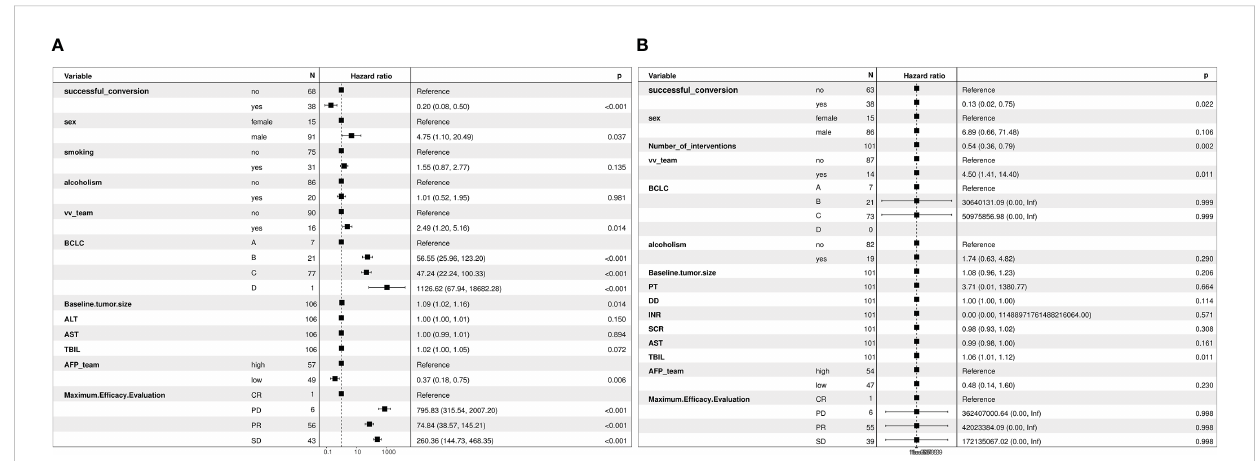
FIGURE 5 (A) Forest plot of multivariate Cox regression analysis of PFS, (B) Forest plot of multivariate Cox regression analysis of